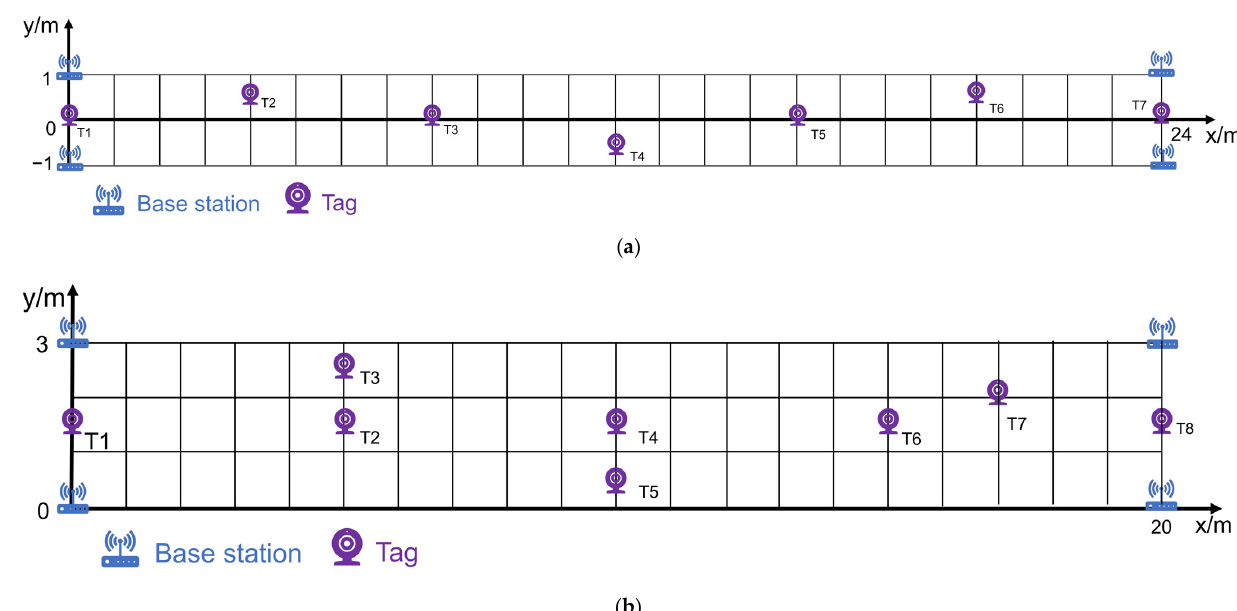
Figure 8. Base station and tag location map: ( a ) Scene A; ( b ) Scene B.